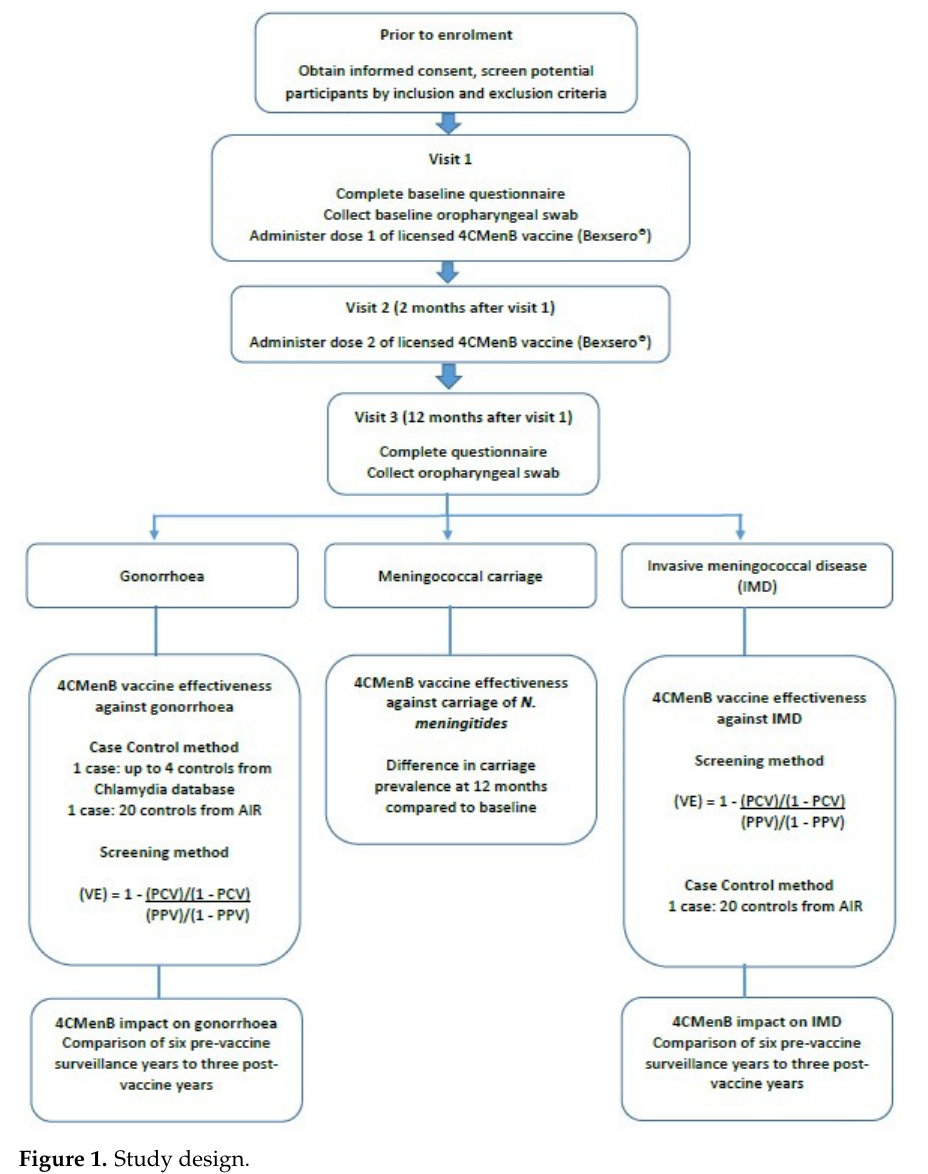
Figure 1. Study Figure 1. Study design.